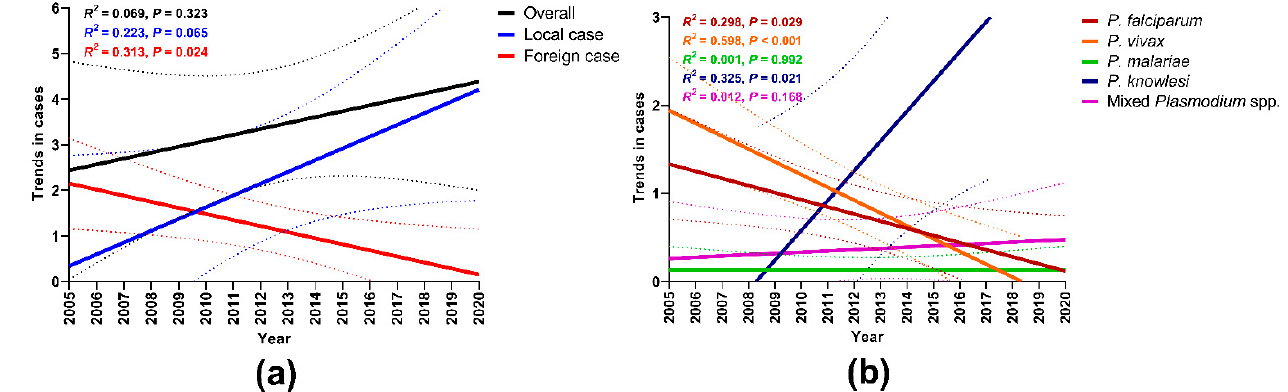
Figure 2. Curve estimation model for malaria cases by ( a ) nationality and ( b ) Plasmodium species. Solid lines show model predicted prevalence and broken lines are 95% confidence intervals (CI).